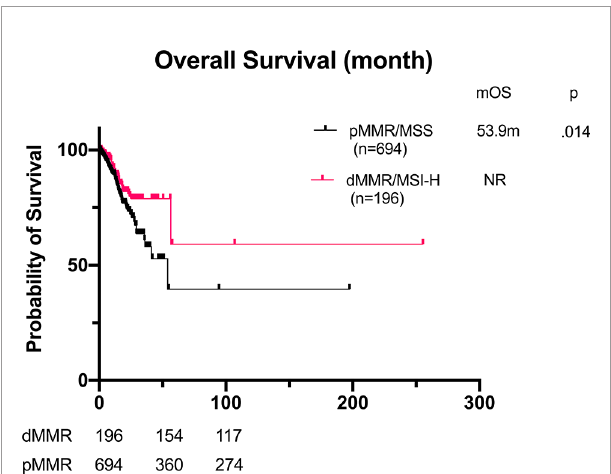
FIGURE 1 | Overallsurvival ofGC patients with dMMR/MSI-H (n = 196) and pMMR(n = 694).mOS: not reached vs . 53.9 months, p = 0.014. GC, gastric cancer; dMMR, de fi cient DNA mismatch repair; MSI-H, microsatellite instability- high;pMMR, pro fi cient mismatch repair; mOS, median